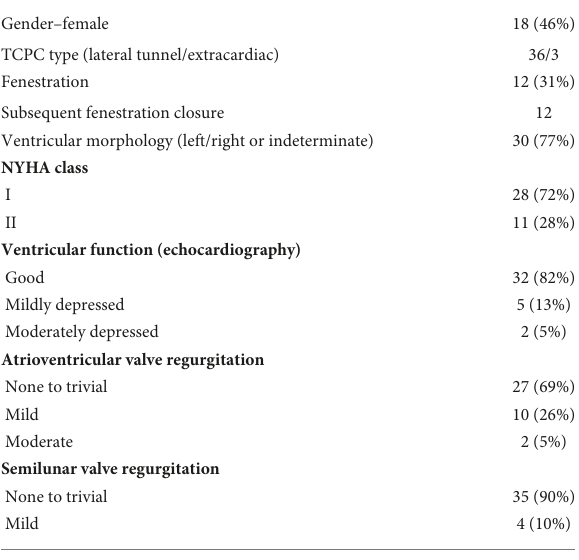
TABLE 1 Patient characteristic ( n = 39).